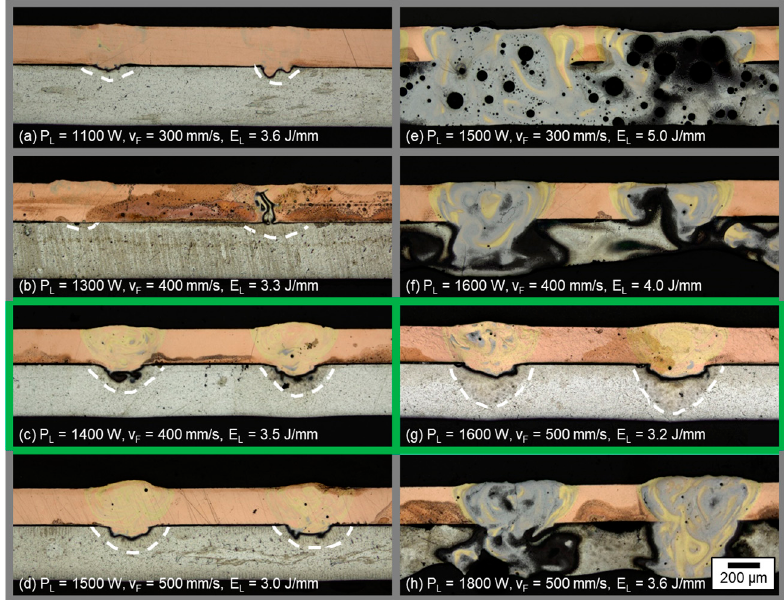
Figure 5. Longitudinal sections of linear stitched welds for different laser powers and feed